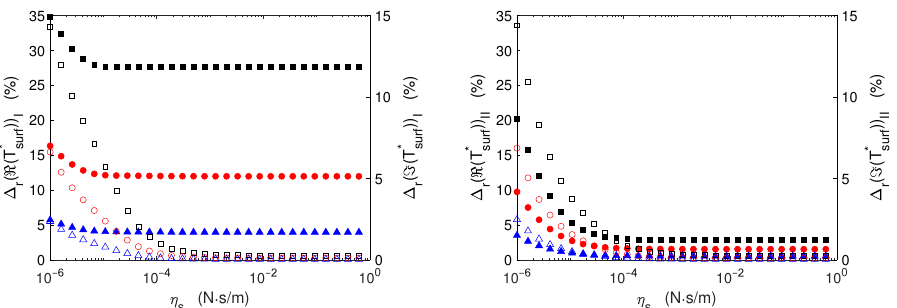
Figure 6. Interfacial drag torque relative differences between the solutions with different mesh sizes )) (solid symbols), taking as a reference the 2520 × 1260 mesh solution for the real part, ∆ r ( (cid:60) ( T ∗ surf )) (open symbols). Black symbols: 200 × 100 mesh. Red symbols: and the imaginary part, ∆ r ( (cid:61) ( T ∗ surf 440 × 220 mesh. Blue symbols: 1000 × 500. Left panel: PV-I, right panel: